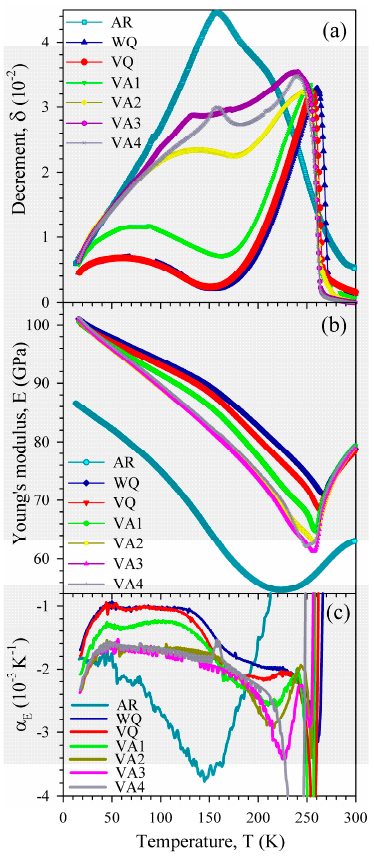
Figure 3. Temperature dependence of the decrement ( a ), effective Young’s modulus ( b ) and temperature coefficient of the Young’s modulus ( c ) of Ni 50.8 Ti 49.2 samples measured on heating at strain amplitude of 10 − 6 in the as-received state (AR) and after different heat treatments (water quenching (WQ), vacuum quenching (VQ), and vacuum annealings (VA1-VA4), see text for details).